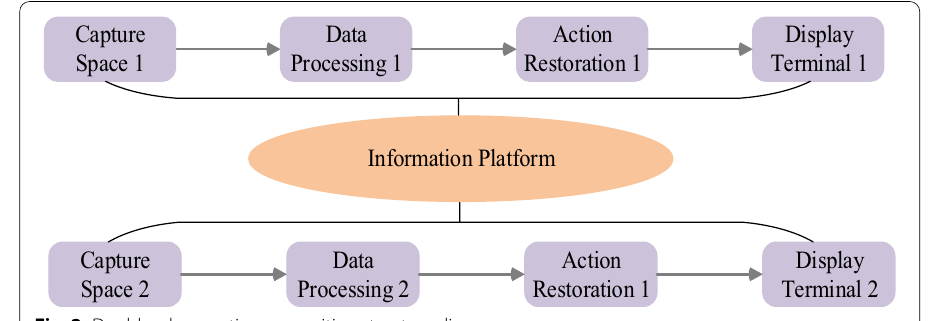
Fig. 2 Double-player action recognition structure